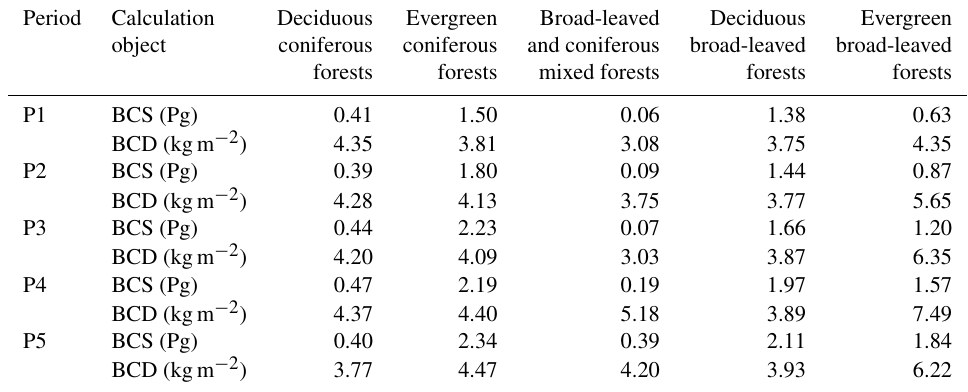
Table 3. BCSs and BCDs for all forest types during the five periods estimated using HASM-S.